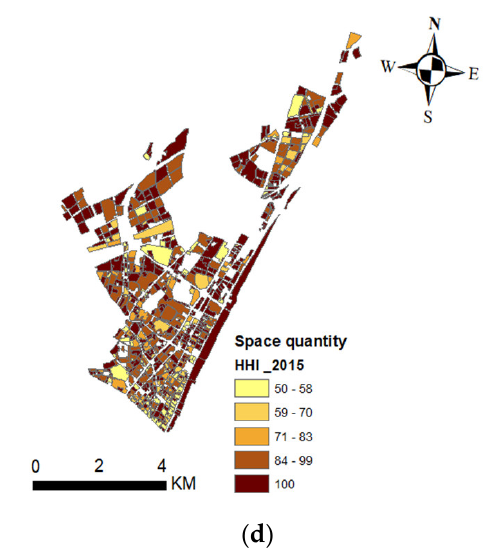
Figure 5. ( a – d ). An entropy index and HH index for the years 2012 and 2015: ( a ) entropy index 2012; ( b ) HH index 2012; ( c ) entropy index 2015; and ( d ) HH index 2015.